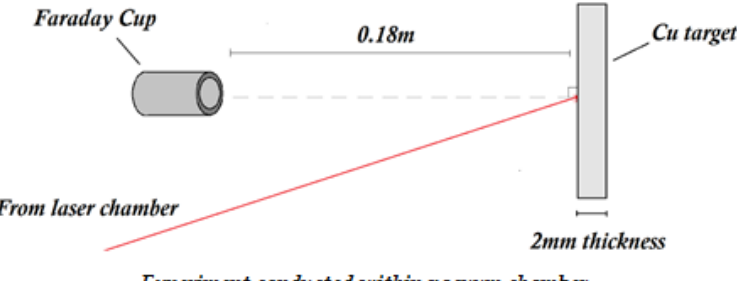
Figure 2. Schematic of laser-target collision chamber with 1030 nm central wavelength laser, 1.5 ps shot duration incident on a 2 mm Cu thickness target. The Faraday cup collector is positioned normal to back scatter. Capacitor/resistor/amplifier setup contained within the Faraday cup.